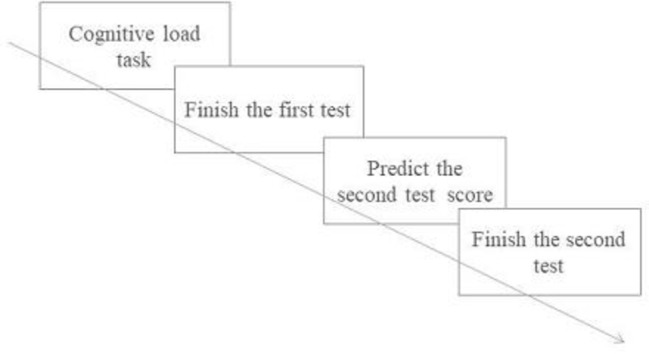
Trials of Experiment 3.